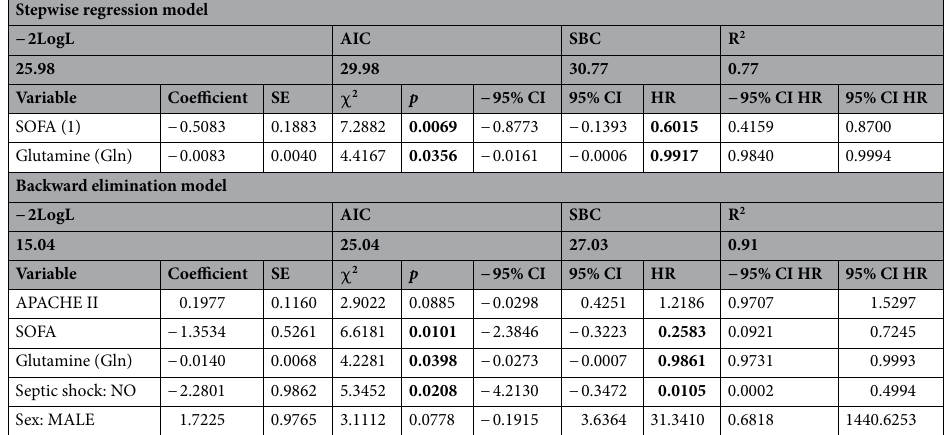
Table 4. Cox proportional hazard models obtained by means of stepwise regression or backward elimination (maximum of 50 iterations). P-values < 0.05 and their corresponding hazard ratios (HR) are marked in bold. AIC, Akaike information criterion; SBC, Schwarz bayesian criterion; SE, standard error; HR, hazard ratio; CI, confidence interval, SOFA, sequential organ failure assessment; Gln,